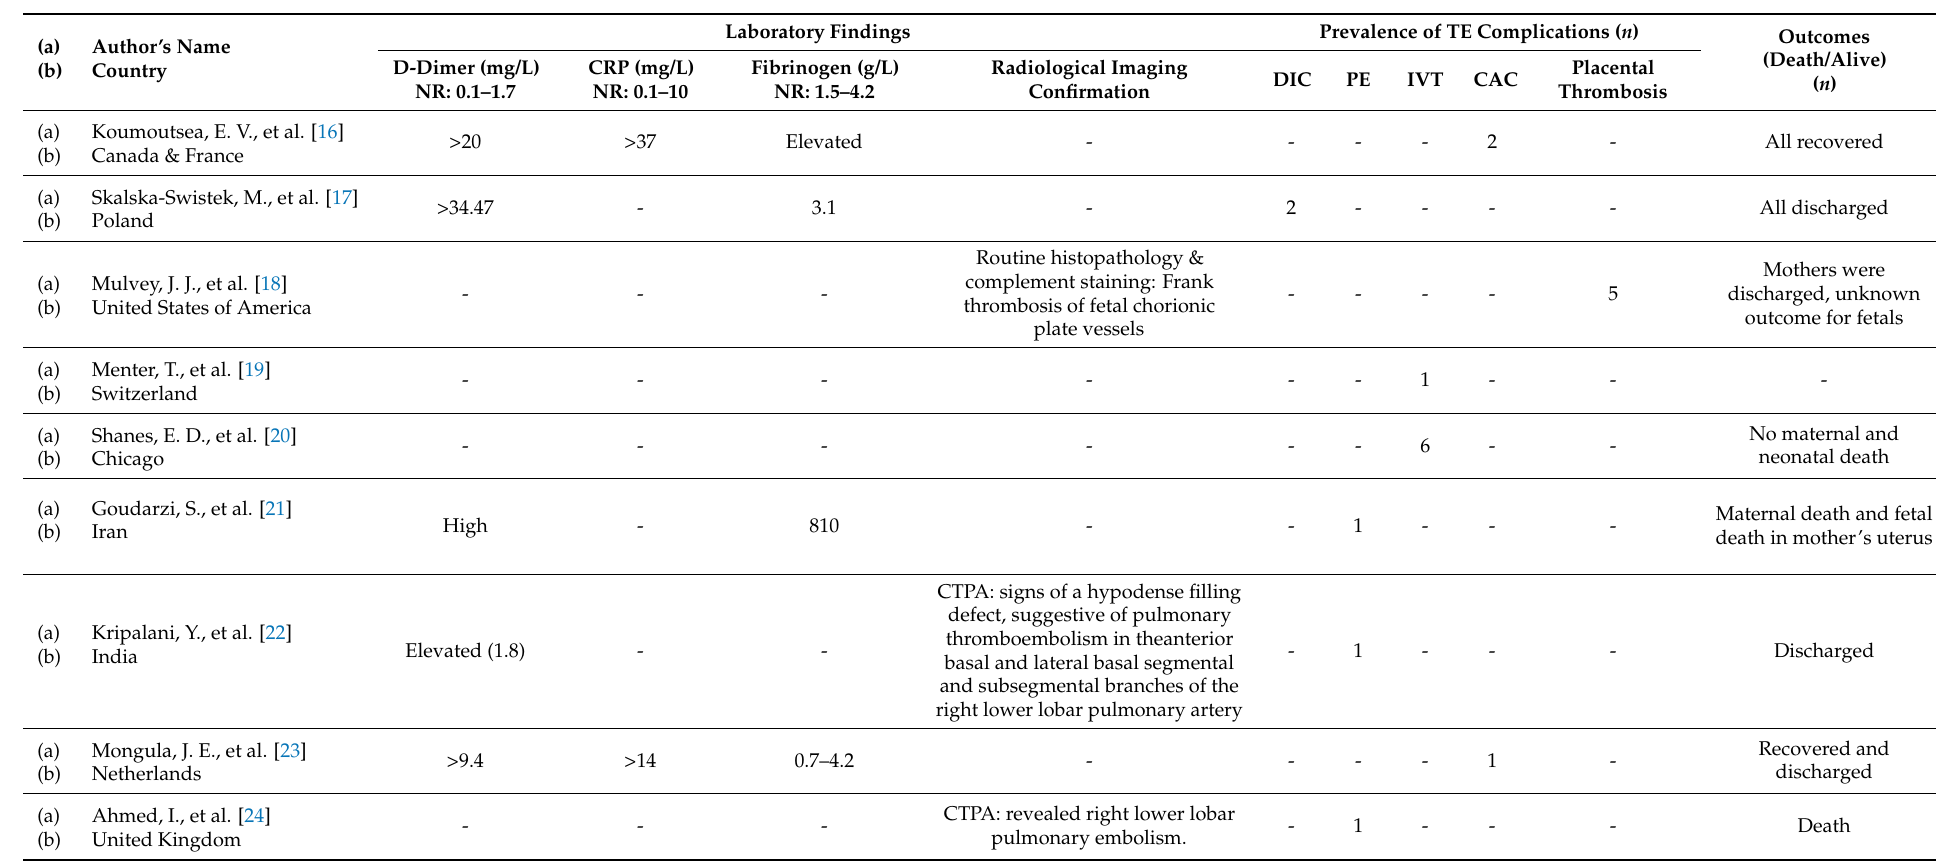
Table 3. Laboratory findings, Prevalence, and Outcomes of case reports/case series reporting thromboembolic (TE) complications among pregnant women infected with